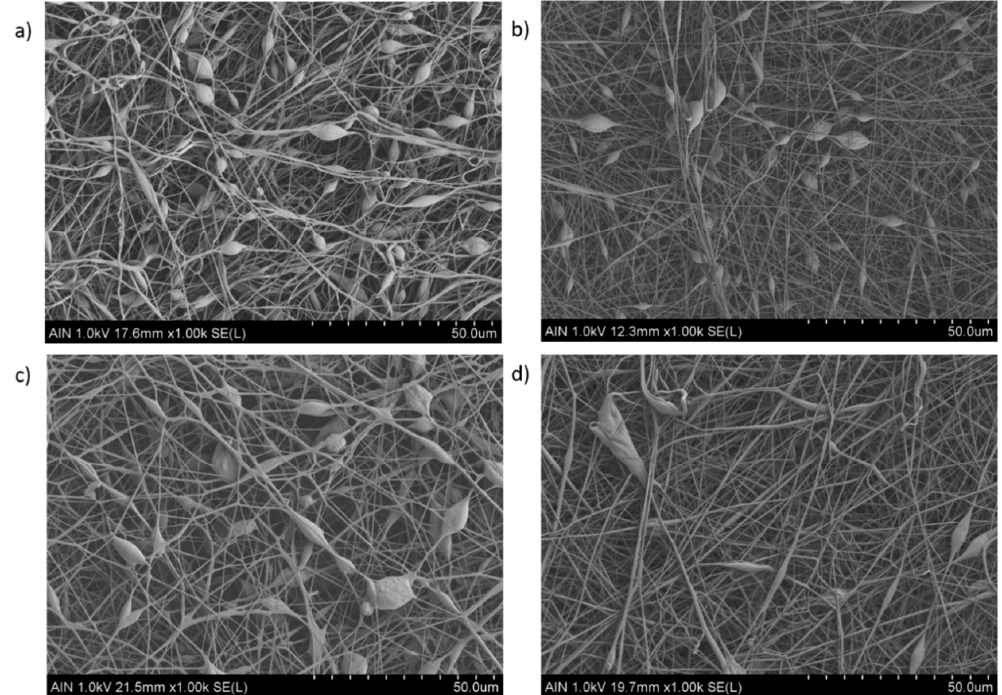
Figure 3. Scanning electron microscopy (SEM) images representing the surface morphologies of the electrospun mats for Sample 5 ( a ), Sample 6 ( b ), Sample 7 ( c ), and Sample 8 ( d ). The scale bar is 50 µm in all images.